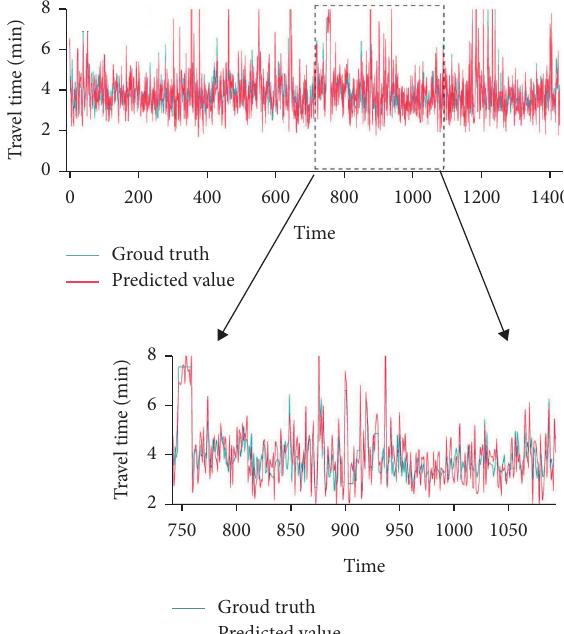
Figure 8: Prediction result of segment 6.